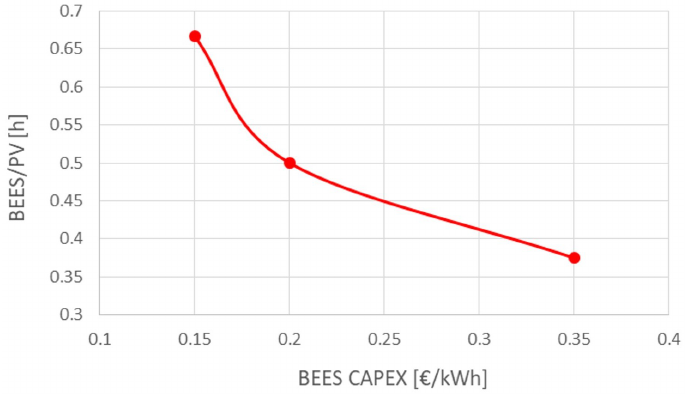
Figure 5. BEES to PV ratio as a function of the BEES